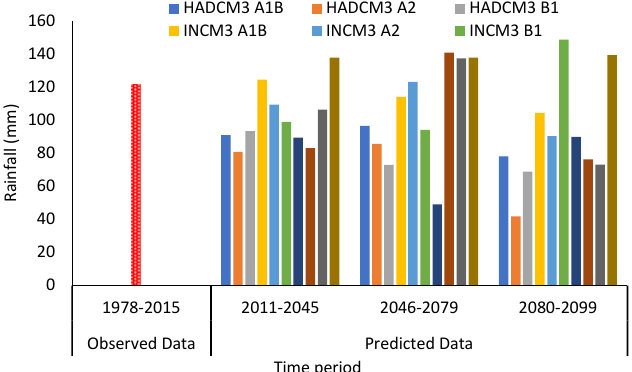
Figure 12. Annual rainfall predicted by the ANN and various GCM models under three emissions scenarios.